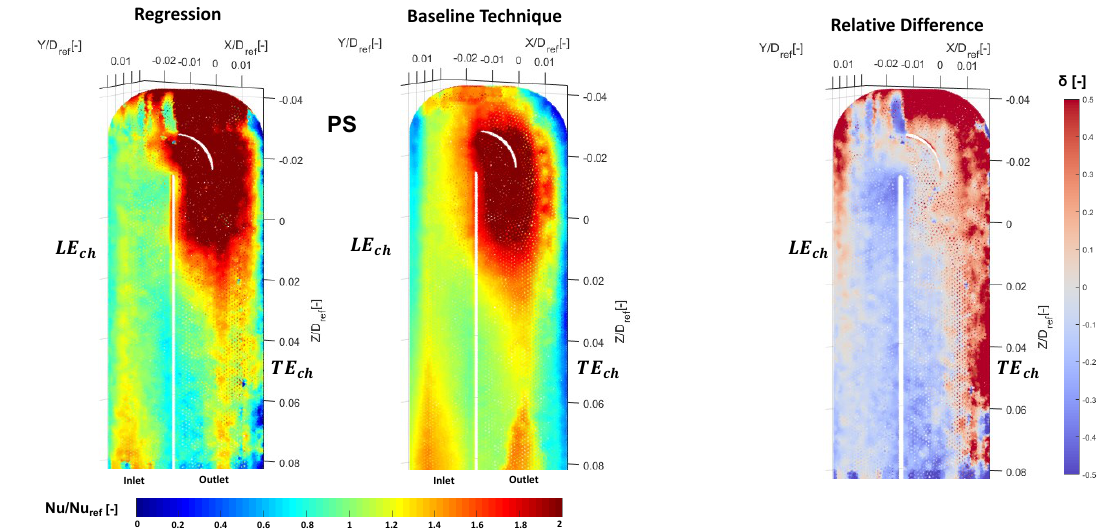
Figure 6. Heat transfer distribution obtained with regression and baseline and their relative